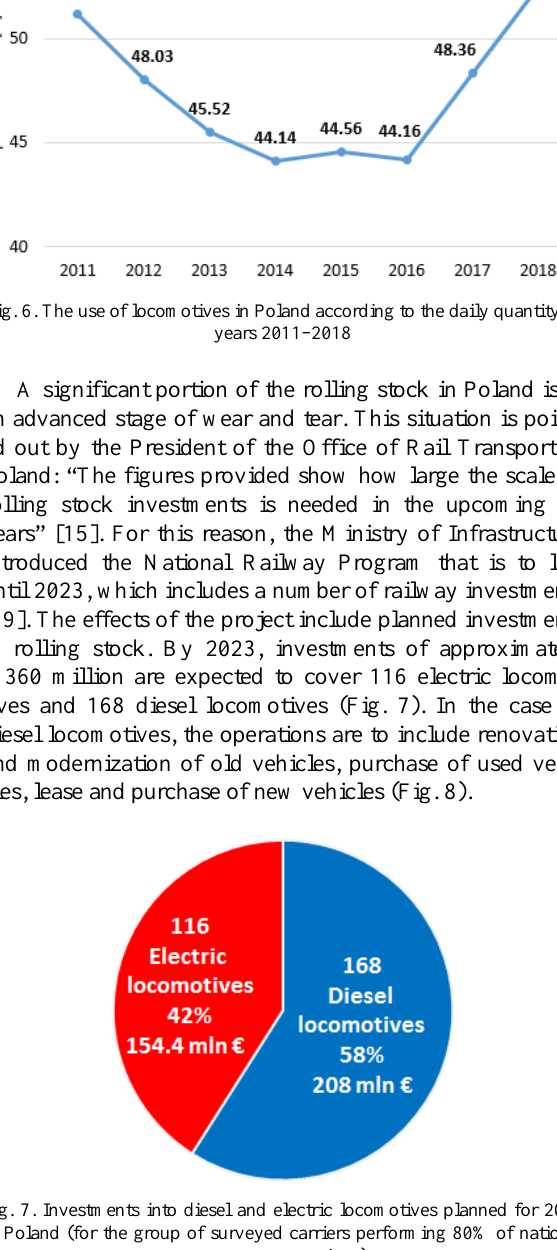
Fig. 8. Number of diesel locomotives included in the planned investments until 2023 in Poland (for the eight surveyed